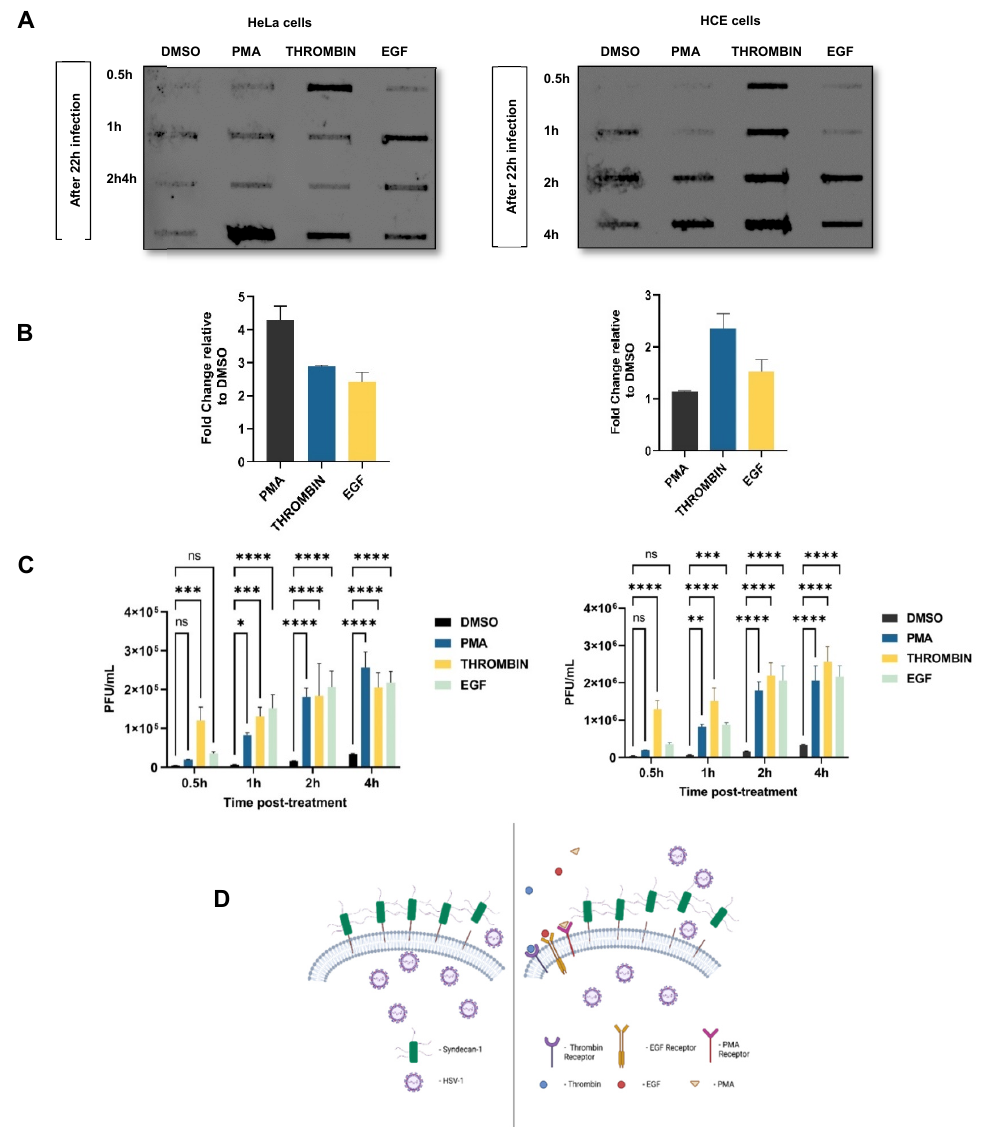
Figure 6. Treatment with PMA, thrombin, or EGF enhances virus release. ( A ) HeLa and HCE cells were infected with HSV-1 (KOS) for 2 h. Then, the media was replaced with complete media for 8 h. Then, the cells were washed thrice by serum-starved media and overlaid with the serum-starved media for 12 h. After a total 22 h of infection, the cells were treated with DMSO, PMA, thrombin, and EGF in serum-free media. At 0.5, 1, 2, and 4, h time points, culture media were collected. The supernatant was used to measure the gD by slot blot analysis. Results are representative of two independent experiments. Representative blots of two independent experiments are shown. ( B ) Densitometry quantification of the slot blot was performed using ImageQuant TL image analysis software, and the results are shown as fold change of gD in the supernatant in the treated cells over DMSO (control)-treated cells. Representative graph of two independent experiments conducted in duplicate is shown. ( C ) HeLa and HCE cells were infected in the similar way as done for the slot blot analysis for analyzing gD in the supernatant and treated in the same way to collect 100 µl of supernatant after each time point of 0.5, 1, 2, and 4 h. The collected supernatants were titered on a Vero cells monolayer. The Results are mean of ± 1 SD of three independent experiments (ns: non-significant; * p < 0.05; * * p < 0.01; ** * p < 0.001; *** * p < 0.0001). ( D ) Diagrammatic representation of the results depicting that the treatment of cells with PMA, thrombin, or EGF (shown on the left side of the diagram) accelerates the process of syndecan-1 shedding in the culture supernatant relative to the non-treated cells (shown on the right side of the diagram) and results in enhanced viral egress. Image was created using Bio Render appli- cation.